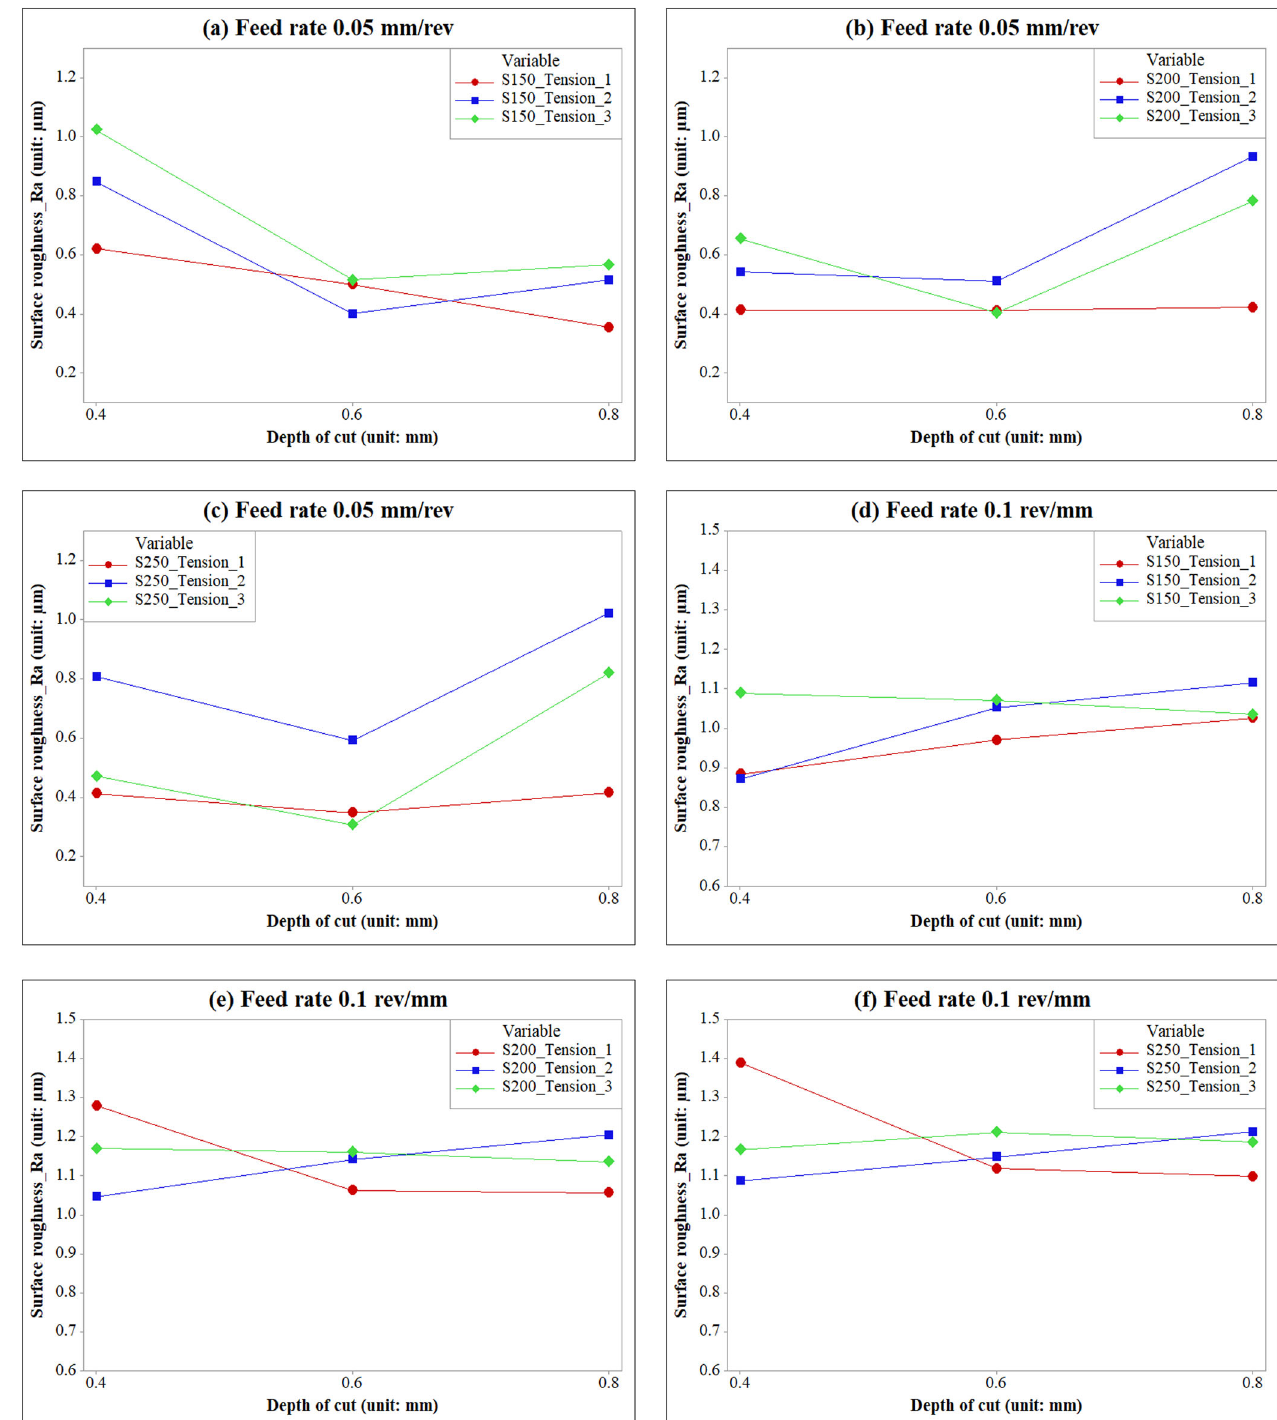
Figure 7. Results of measured surface roughness. ( a ) Cutting at a feed speed of 0.05 mm/rev and a cutting speed of 150 m/min; ( b ) cutting at a feed speed of 0.05 mm/rev and a cutting speed of 200 m/min; ( c ) cutting at a feed speed of 0.05 mm/rev and a cutting speed of 250 m/min; ( d ) cutting at a feed speed of 0.1 mm/rev and a cutting speed of 150 m/min; ( e ) cutting at a feed speed of 0.1 mm/rev and a cutting speed of 200 m/min; and ( f ) cutting at a feed speed of 0.1 mm/rev and a cutting speed of 250 m/min.